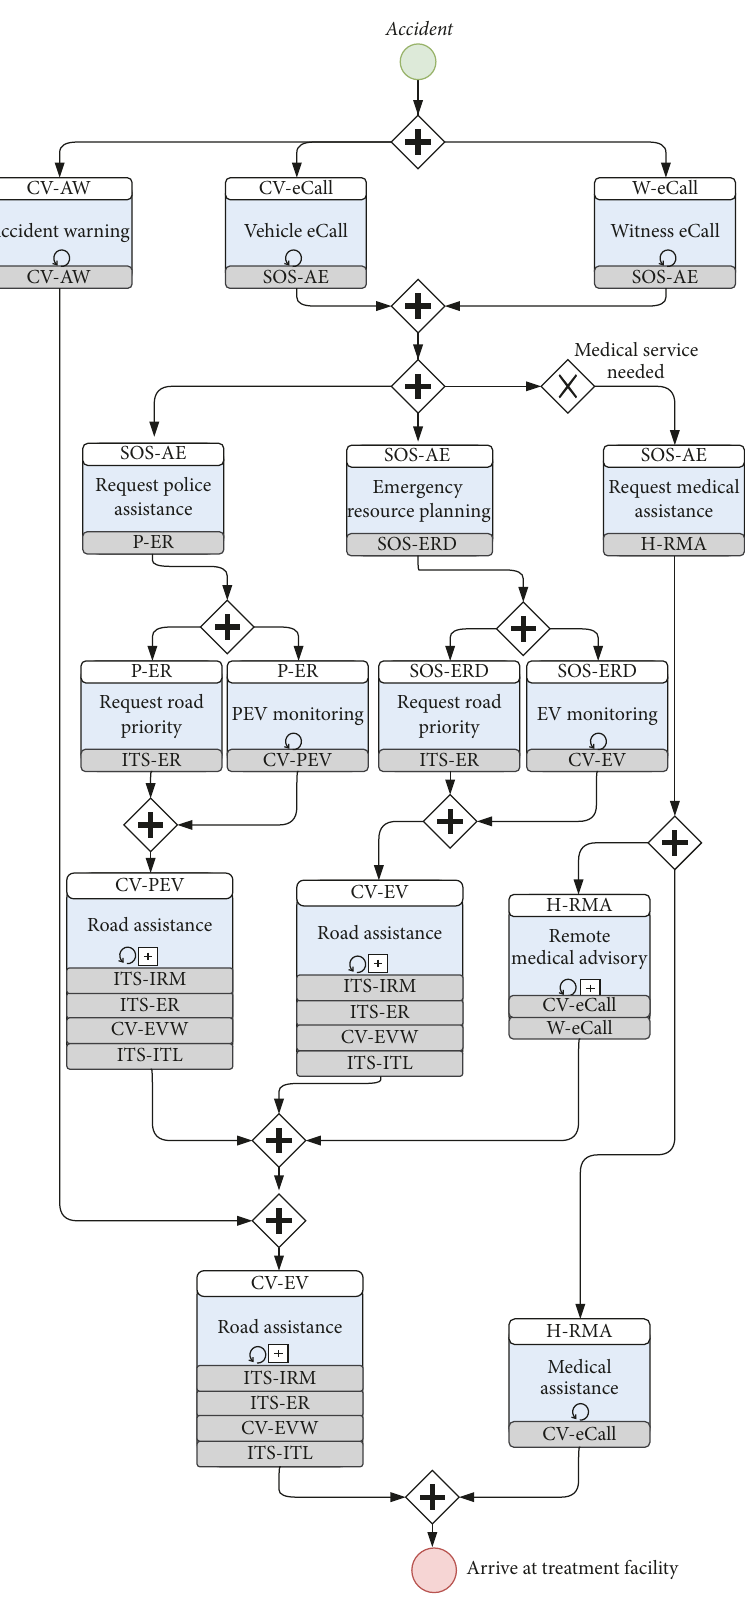
Figure 5: AEMS service